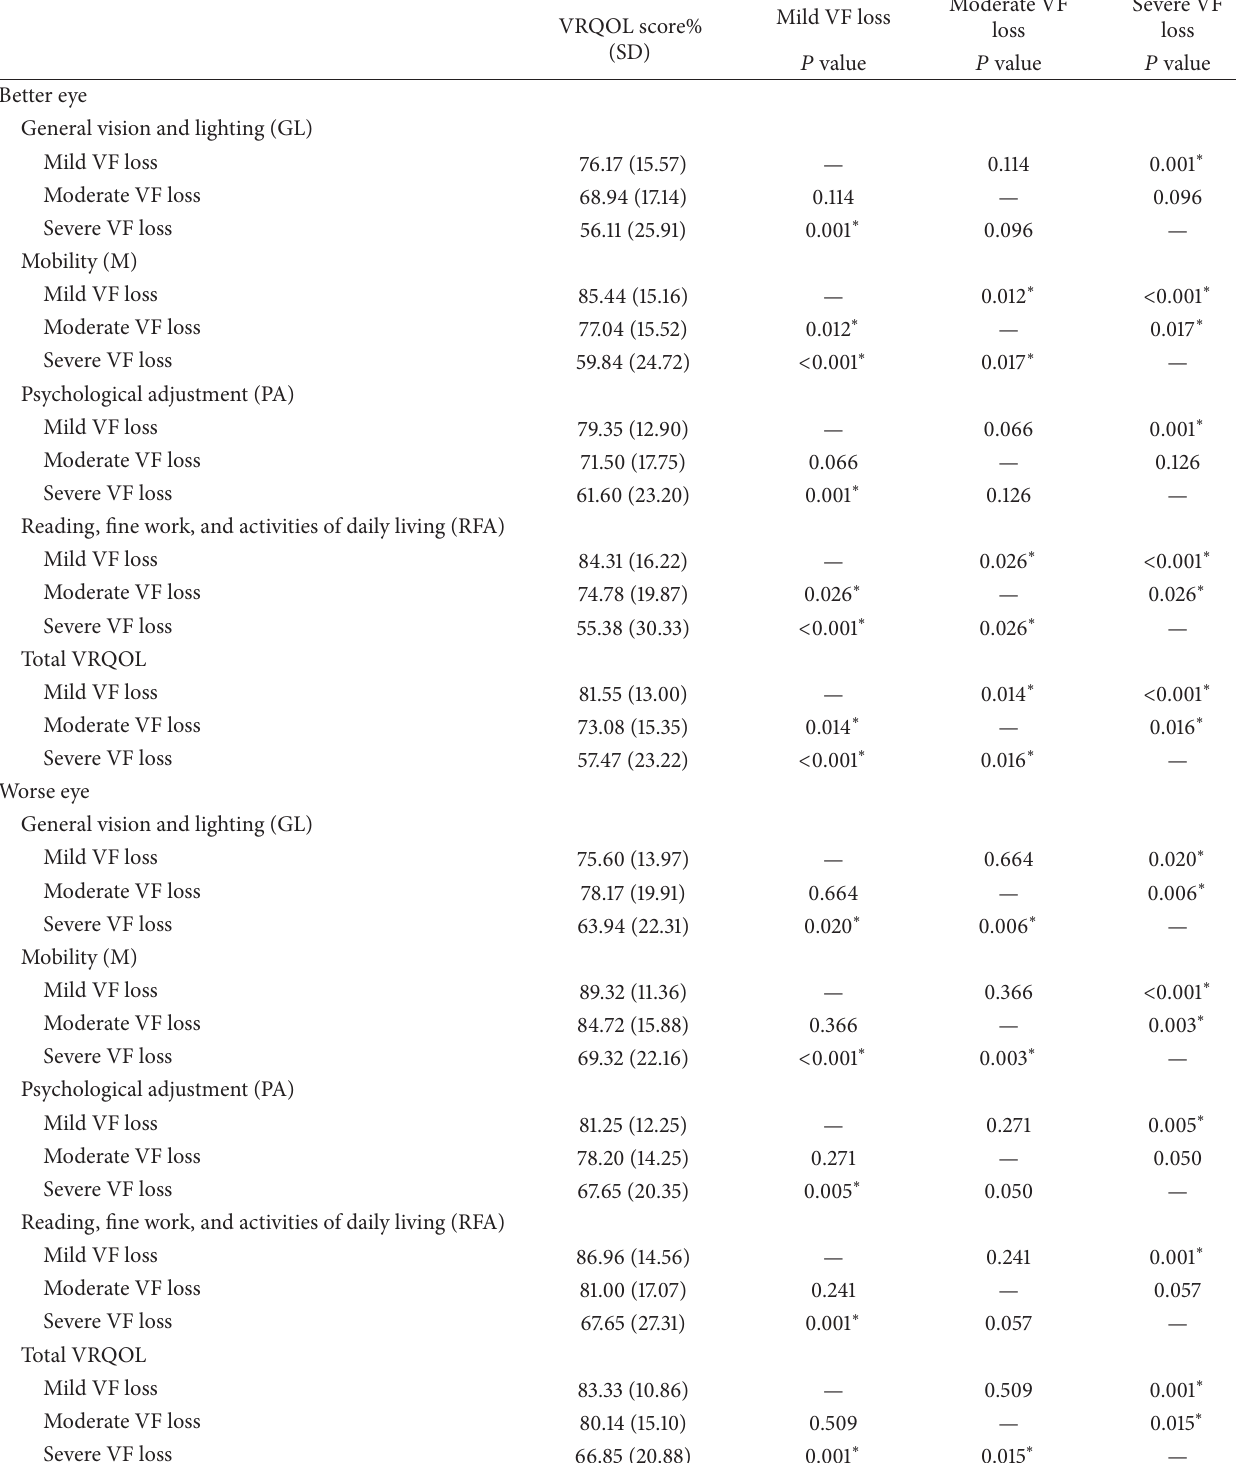
Table 3: Relationship between vision health-related quality of life (VRQOL) score calculated for separate factors and visual fields (VF)